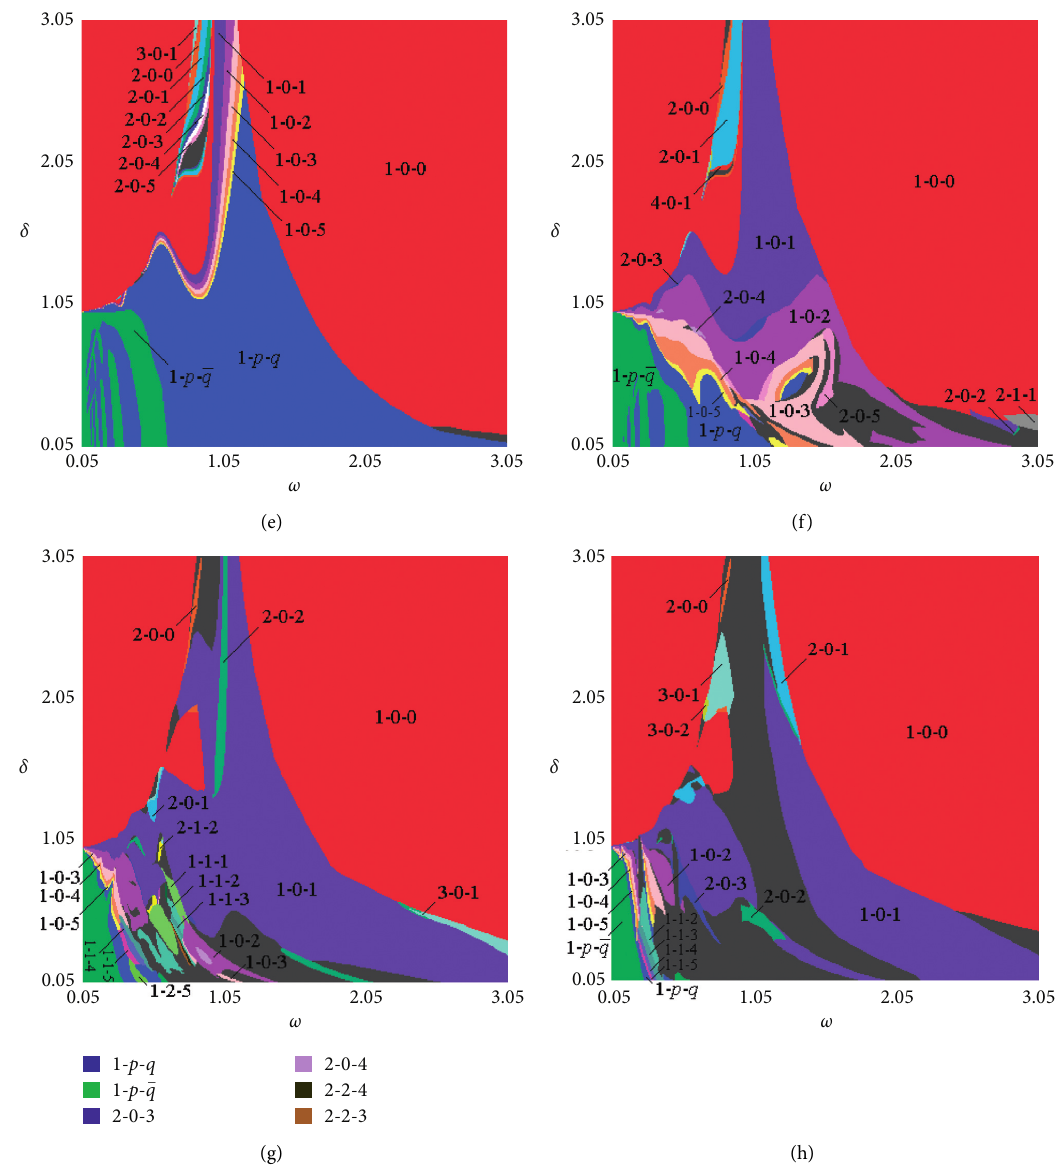
Figure 8: Under different mass ratios μ M : μ m � 0.25; (c) M 1